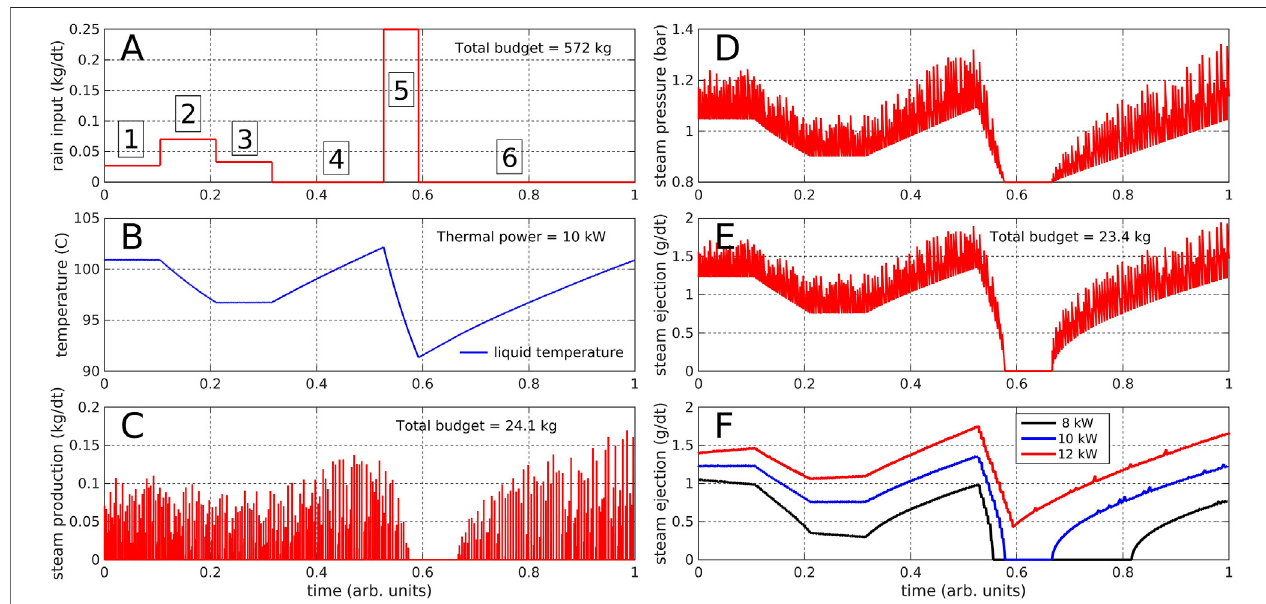
Figure 8A . The adjustable parameters of the model are the heating power, the meteoric water input, the reservoir volume, the initial volume of liquid in the reservoir and the vent conduit diameter and length. Tens of trials were performed with different values of these parameters. In all cases, the models reached an equilibrium functioning point but, depending on the values chosen for the parameters, not all possible phenomena were observed. For instance, if the vent conduit diameter is too large, no increase of the steam pressure in the reservoir is observed. In the example we show here, we chose to only vary the rain input and keep the conduit geometry, the reservoir volume and the heating power constant in order to mimic the most probable situation on La Soufrière. The other plots of Figure 8 represent the liquid temperature ( Figure 8B ), and